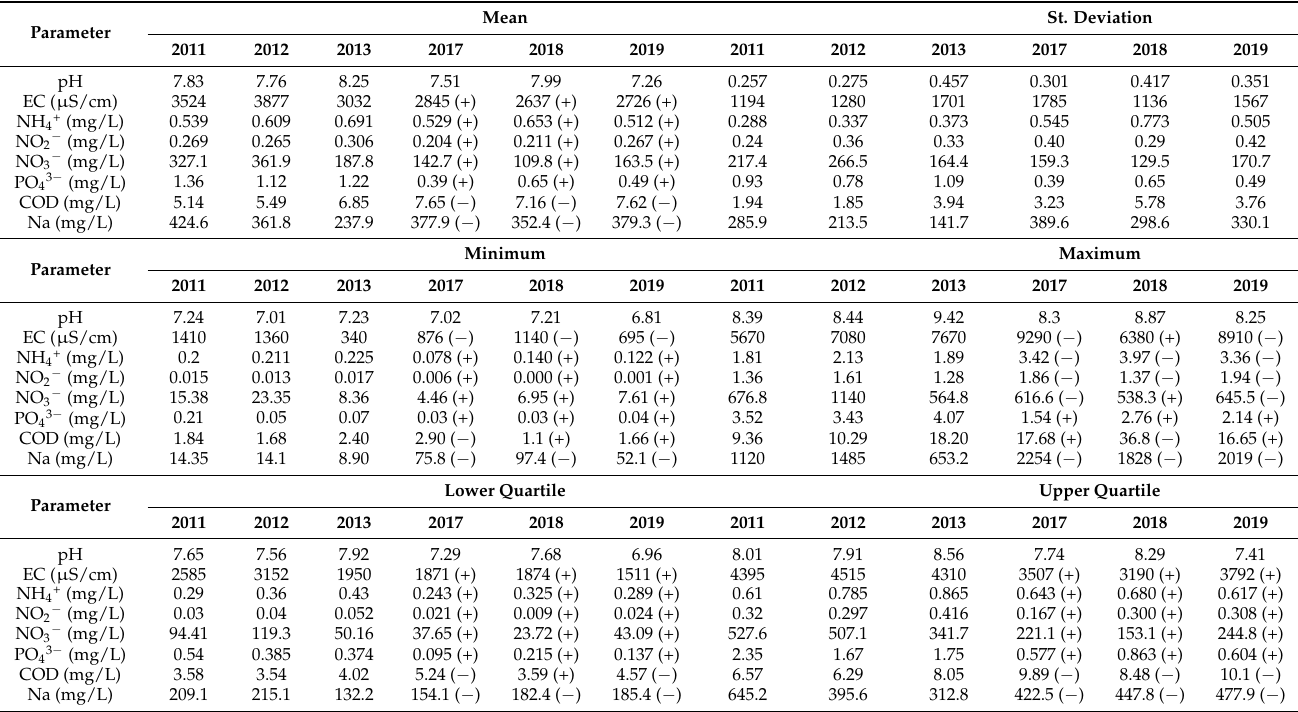
Table 1. Descriptive statistics of the examined hydrochemical parameters. (+) indicates positive changes compared to the 2013 reference year, ( − ) indicates negative changes based on the contamination limit for the given